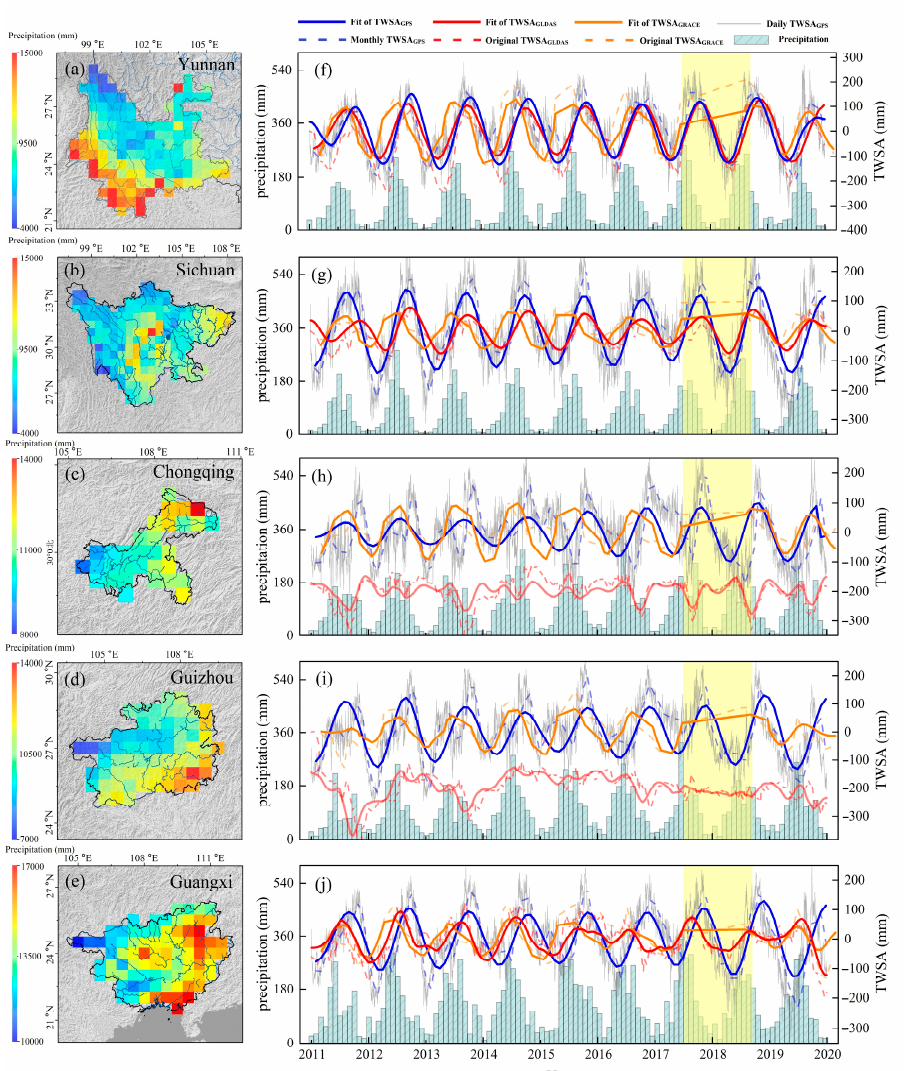
Figure 11. The comparison with precipitation in each province; ( a – d ) show the spatial distribution of the total precipitation; ( f – J ) describe the result of GPS, GRACE, GLDAS solutions, and precipitation in each province.